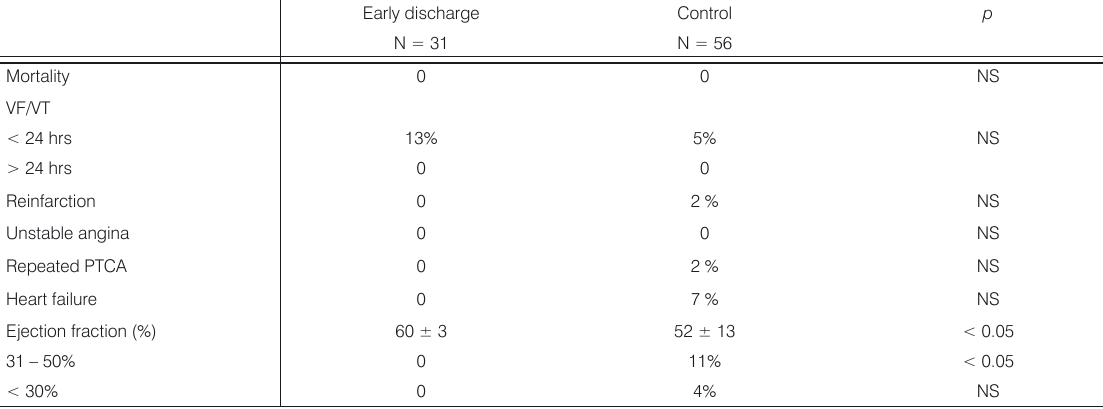
Table 3. In hospital course. Results are presented as percentages and mean ± SD where appropriate.